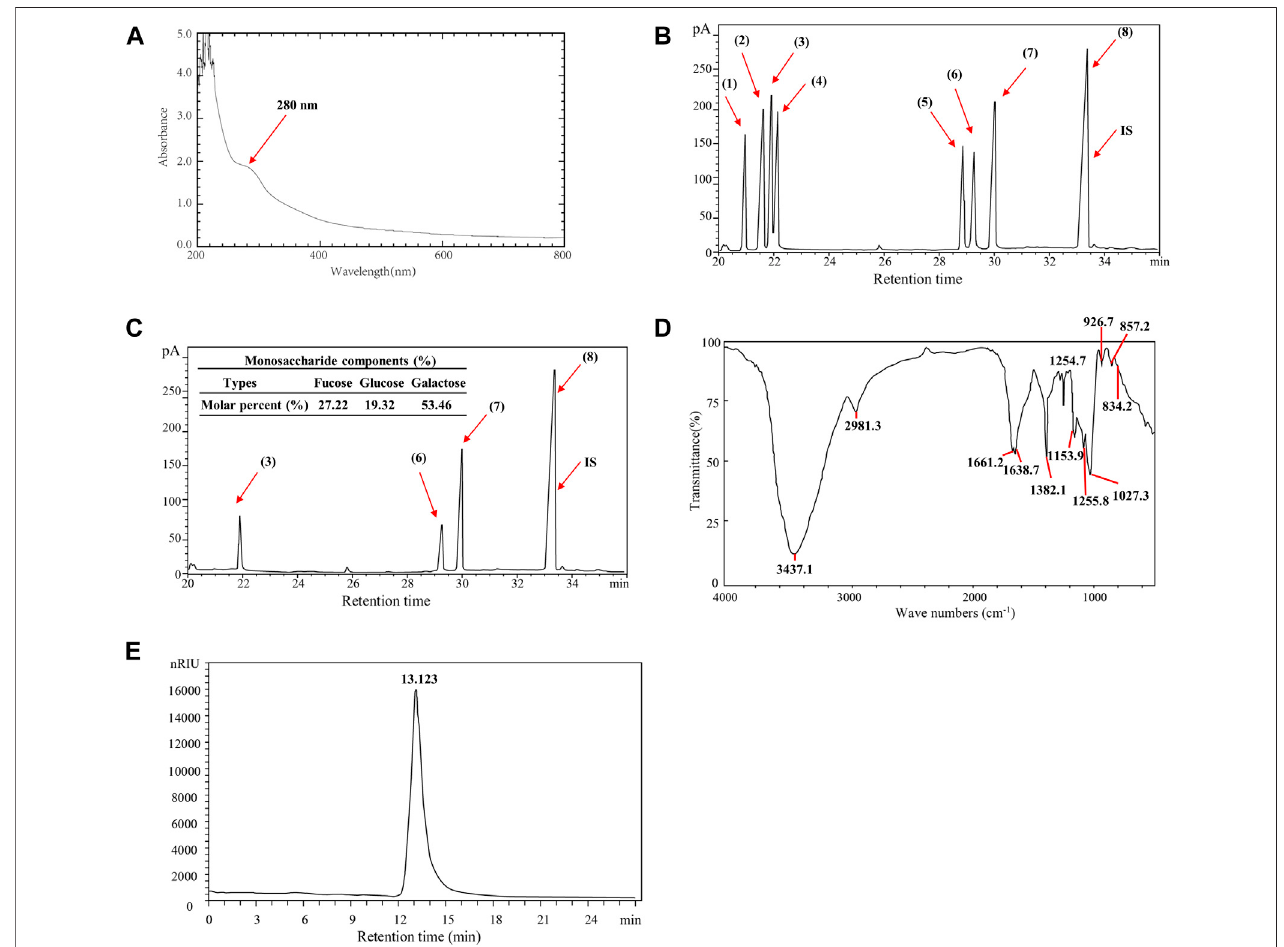
FIGURE1| Identi fi cationofphysicalandchemicalpropertiesofSPUP; (A) UV-visspectraofSPUP; (B,C) GCdiagramofstandardmonosaccharideandSPUP; (D) infrared spectrum of SPUP; (E) HPGPC chromatogram of SPUP. Note: 1): rhamnose; 2): arabinose; 3): fucose; 4): xylose; 5): mannose; 6): glucose; 7): galactose; 8): inositol; IS: internal standard. SPUP inhibited the proliferation of OC cells.